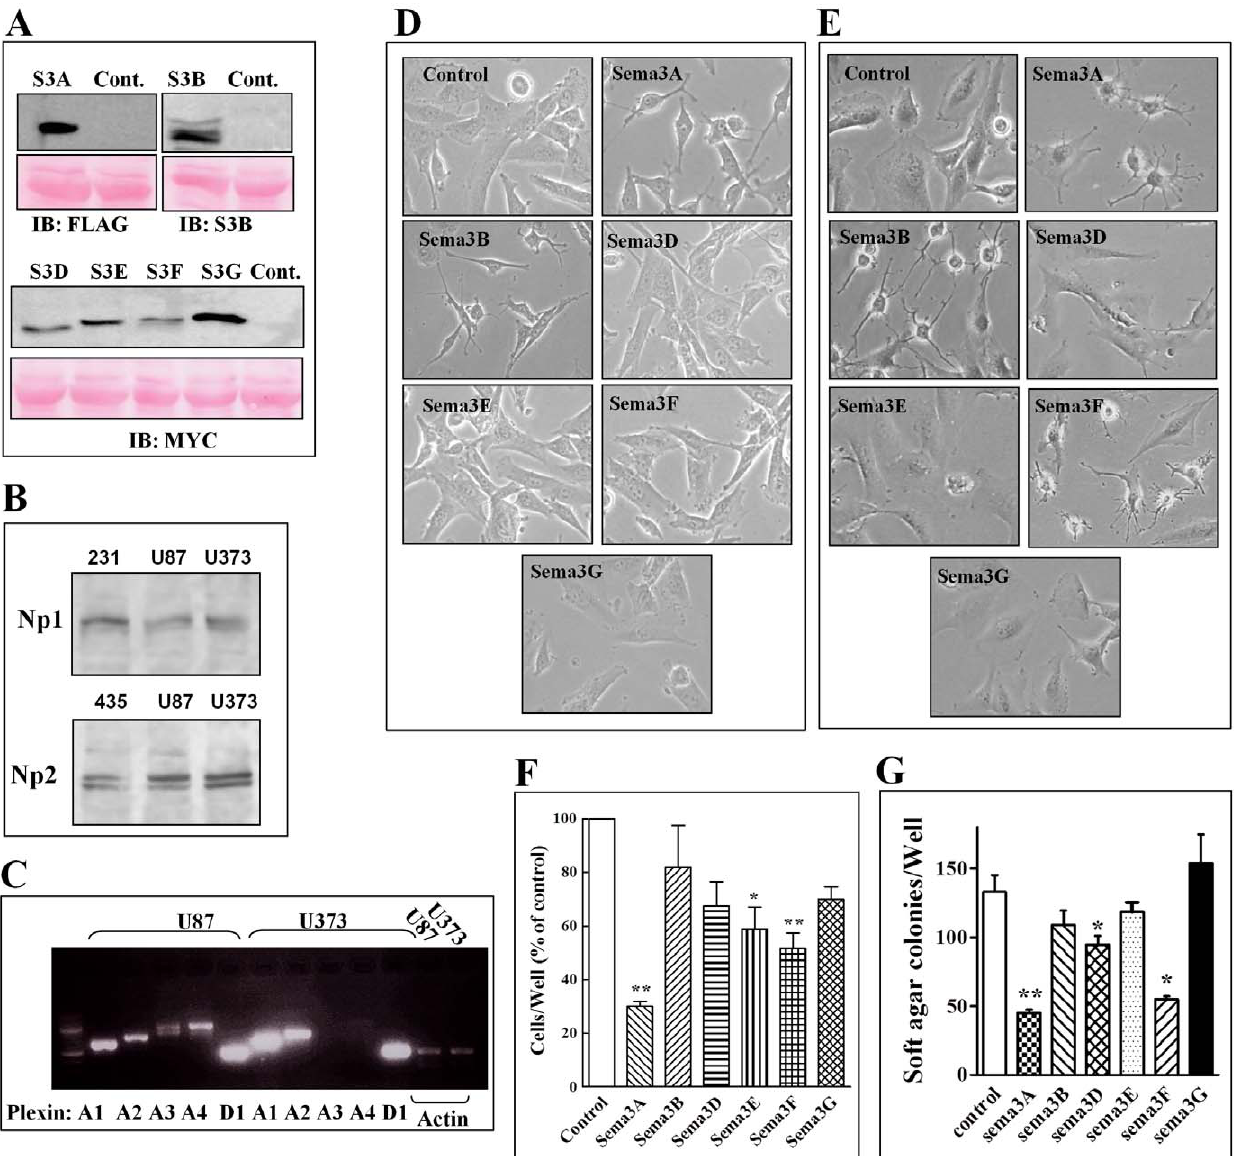
Figure 1. The effect of the expression of various class-3 semaphorins on the morphology and proliferation of U87MG cells: (A) Lentiviruses containing the full length cDNAs encoding six semaphorins (S3A-G) or empty control lentiviruses (Cont.) were used to infect U87MG cells. Sema3A has a FLAG epitope tag, S3B has no tag and the rest of the semaphorins were labeled with a myc epitope tag. The presence of the designated recombinant semaphorins in aliquots of serum free medium derived from equal numbers of U87MG cells (5 6 10 5 cells/well) expressing the different sema3s. The serum free medium was conditioned for 48 h and 40 m l aliquots were then assayed for the presence of the designated semaphorins by western blot analysis (upper panels). To verify equal protein loading the blot was also stained with ponceau-red. Shown is a ponceau-red stained 60 KDa protein found in the serum free medium (B) Cell lysates were prepared from U87MG or U373MG cells as described. The content of neuropilin-1 (Np1) and neuropilin-2 (Np2) in aliquots of cell lysates (50 m g protein) were determined by western blot analysis as described. Cell lysates from neuropilin-1 expressing MDA-MB-231 cells and neuropilin-2 expressing MDA-MB-435 cells served as positive controls [14]. (C) Reverse PCR was performed using total RNA isolated from U87MG (U87) or U373MG (U373) cells in order to detect the expression of mRNA encoding PlexinsA1–A4 (A1–A4) and PlexinD1 (D1) as described. Expression of b -actin (Actin) mRNA was used as a loading control. (D) U87MG cells infected with control lentiviruses (Control) or with lentiviruses directing expression of the designated semaphorins were cultured in cell culture dishes and photographed. (E) U87MG cells were seeded (1 6 10 4 cells/well) in 12 well plates. The next day cells were incubated with conditioned mediums derived from HEK293 cells expressing the various recombinant semaphorins. Cells were photographed after a 30 minute long incubation. (F) U87MG cells infected with empty lentiviruses (Control) or with lentiviruses directing expression of the designated recombinant semaphorins were seeded in triplicate in 24 well dishes and their proliferation measured as described in materials and methods. Each bar represents the average of three independent experiments each of which was done in triplicates. (G) Single cell suspensions of U87MG cells infected with empty control lentiviruses (Control) or U87MG cells expressing the designated class-3 semaphorins were seeded in triplicates in soft agar as described in materials and methods. Colonies were allowed to develop for 21 days. Colonies were then stained with crystal violet and microscopic fields photographed. Colonies with a diameter exceeding 100 m m were counted. The average number of colonies in triplicate wells was calculated. Shown is a representative experiment from two experiments which produced similar results.